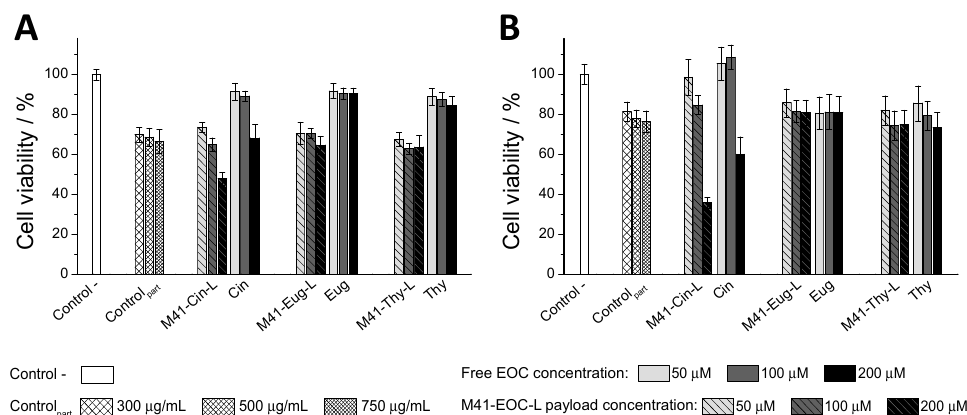
Figure 7. Cell viability of Caco-2 cells treated with the free EOCs and M41-EOC-L for ( A ) 24 h and ( B ) 48 h. Cell viability of free-EOCs treated cells (solid bars) and M41-EOC-L treated cells (striped bars) was compared with non-treated cells as negative control (empty white bars) and cells treated with the M41-RhB-L (striped white bars). Positive control (M41-RhB-L) bars have increasing density-mesh for increasing particle-concentration: 300, 500 and 750 µ g/mL. EOC concentration, both as free compounds or as the microdevices’ released payload, was increased from 50 µ M (light gray bars) to 100 µ M (dark gray bars) and finally 200 µ M (black bars). To achieve this payload concentration, the tested particle concentration of the different M41-EOC-L microdevices was: 75, 150 and 300 µ g/mL for M41-Cin-L; 125, 250 and 500 µ g/mL for M41-Eug-L; and 190, 375 and 750 µ g/mL for M41-Thy-L. Data correspond to the average of two different experiments (8-well per experiment), and error bars represent their standard deviation.